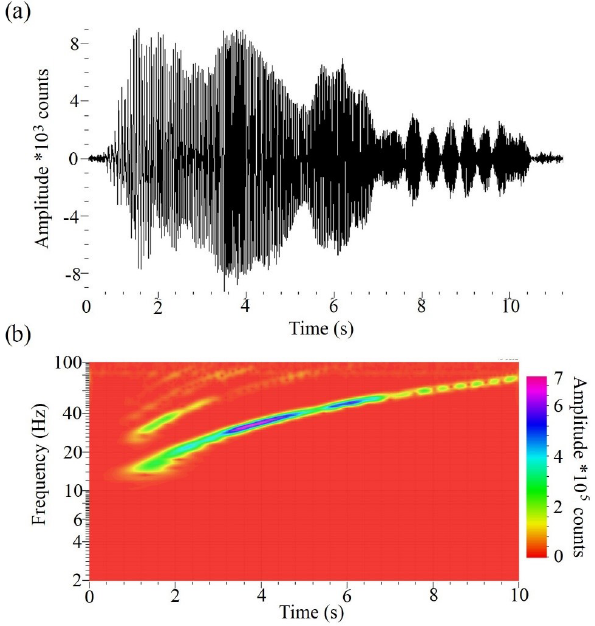
Figure 16. An example of Vibroseis © sweep, recorded by a wire- less sensor placed near the vibrator in the XSoDEx experiment: (a) seismogram; (b) spectrogram showing the frequency content of a vibrator